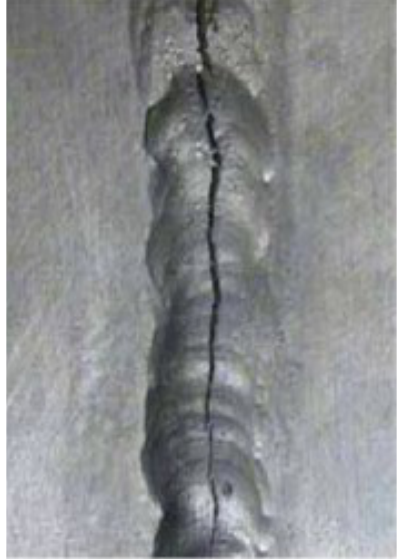
Figure 3. Weld crack adapted from